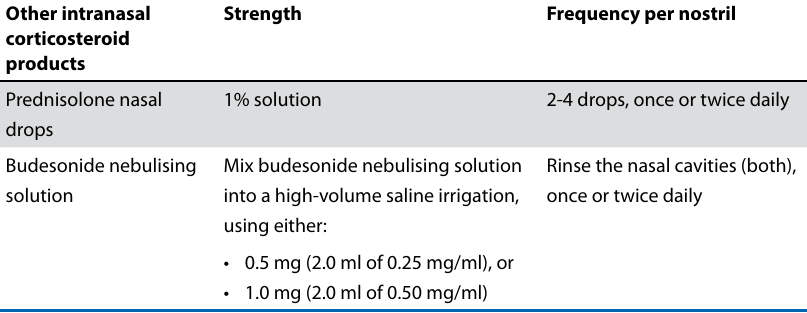
Table IV: Other intranasal corticosteroid products